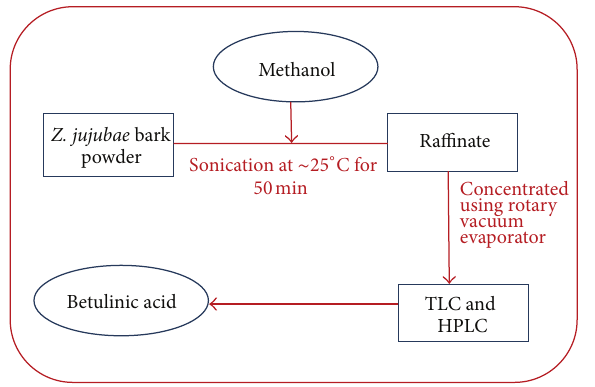
Figure 3: Line diagram for ultrasonic assisted extraction method.